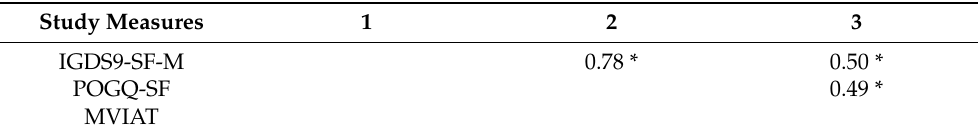
Table 3. Intercorrelations among study